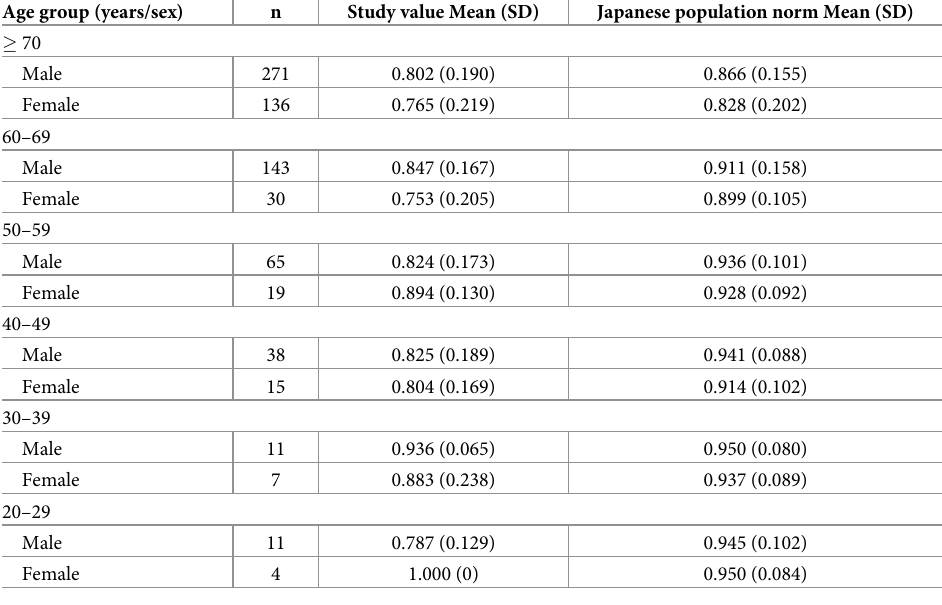
Table 5. Mean EuroQOL—5 Dimension index score, compared with the age- and sex-matched Japanese popula- tion